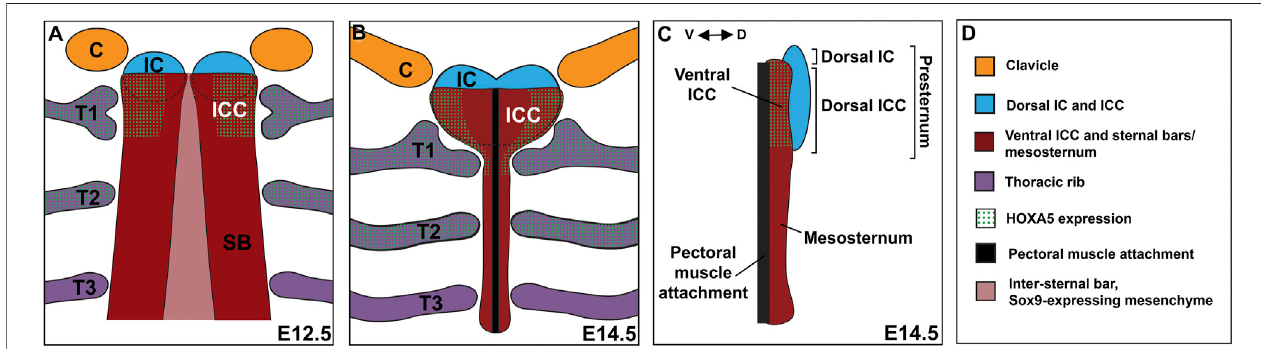
FIGURE 9 | The mammalian presternum is a composite structure with dorsal-ventral organization and molecularly distinct domains. (A) Schematic of sternum developmentinanE12.5embryo.Theclavicles(orange)anddorsal IC/ICC mesenchymeformaspairedcondensationsthatexpresslowlevelsofSOX9.TheventralICC ofthepresternumappearsasaregionofhighSOX9expressionthatiscontinuouswiththeposteriorsternalbars(SB).HOXA5isexpressedinboththeventralICCandrib 1, marking the site of rib 1 attachment to the sternum. Rib 2 also expresses high levels of HOXA5. SOX9 expression can be seen in a stream of cells that cross the midlinebetweenthesternalbars. (B) SchematicofsternumdevelopmentinanE14.5embryo.ByE14.5sternalbarfusionismostlycompleteandthepresternumcanbe seentohaveamorphologydistinctfromtherestofthesternum.TheclaviclesarticulatewiththedorsalIC,whilethe fi rstribcontactstheHOXA5-expressingventralICCin twoplaces.Thepectoralmusclesattachalongtheventralmidlineofthesternum. (C) SideviewofanE14.5sternumshowingdorsalventralregionalization.ThedorsalIC and ICC (blue) form a distinct element, while the ventral ICC appears continuous with the sternal bars. HOXA5 speci fi cally marks the ventral ICC. (D) Key for coloring in (A – C)